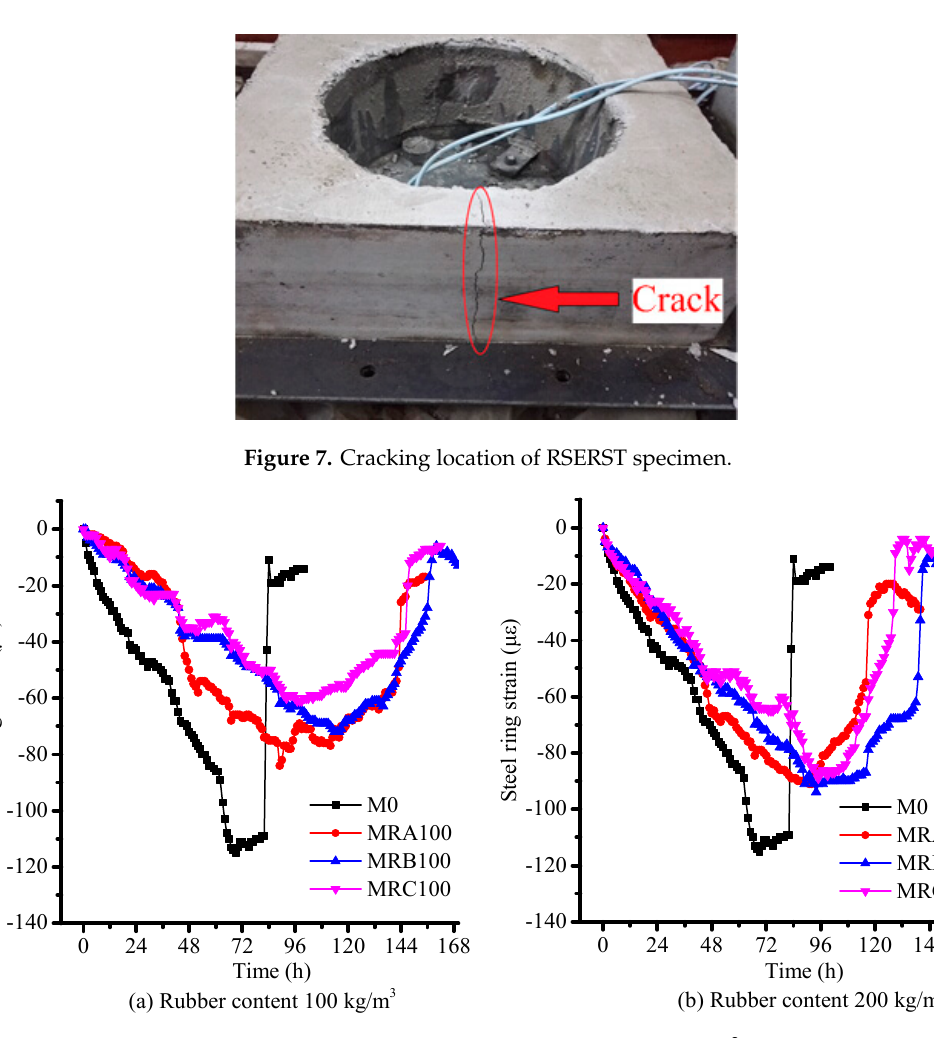
Figure 8. Strain obtained from the RSERST. ( a ) Rubber content 100 kg / m 3 ; ( b ) Rubber content 200 kg / m 3 .